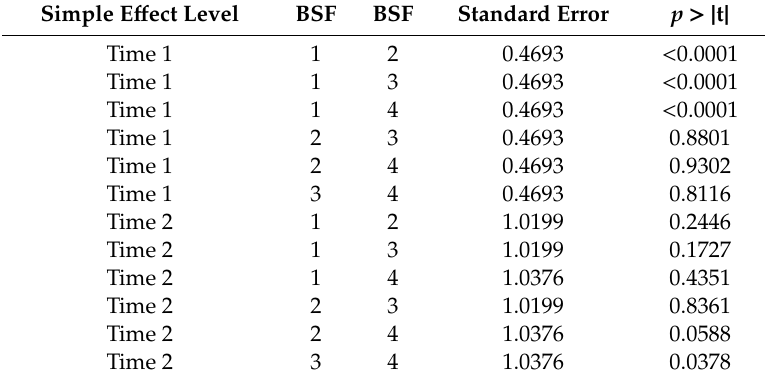
Table 4. Simple e ff ect comparisons of filter ime least squares means by time adjustment for multiple comparisons: Tukey.